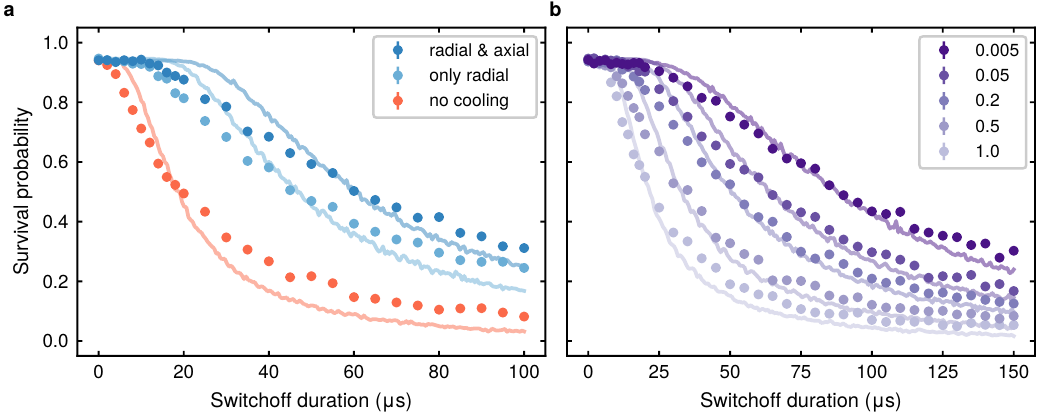
Figure 4: Survival probability for different trap off times. a. Comparison of atoms with Raman sideband cooling (dark blue), with only cooling the radial direction (light blue) and with no additional cooling (orange). b. Full cooling of radial and axial axes, but the trap power before the switch-off is varied. The label is the ramp- down factor from 1 (no rampdown) down to 0.005. The solid lines are numerical simulations of the survival